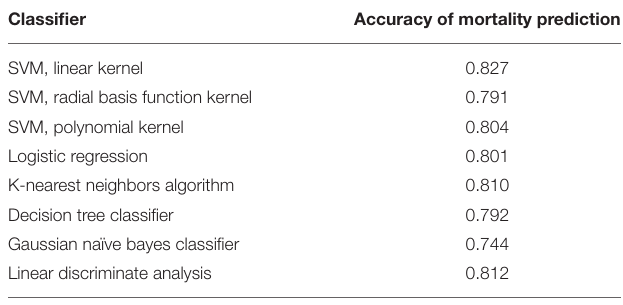
TABLE 2 | Classifier comparison.